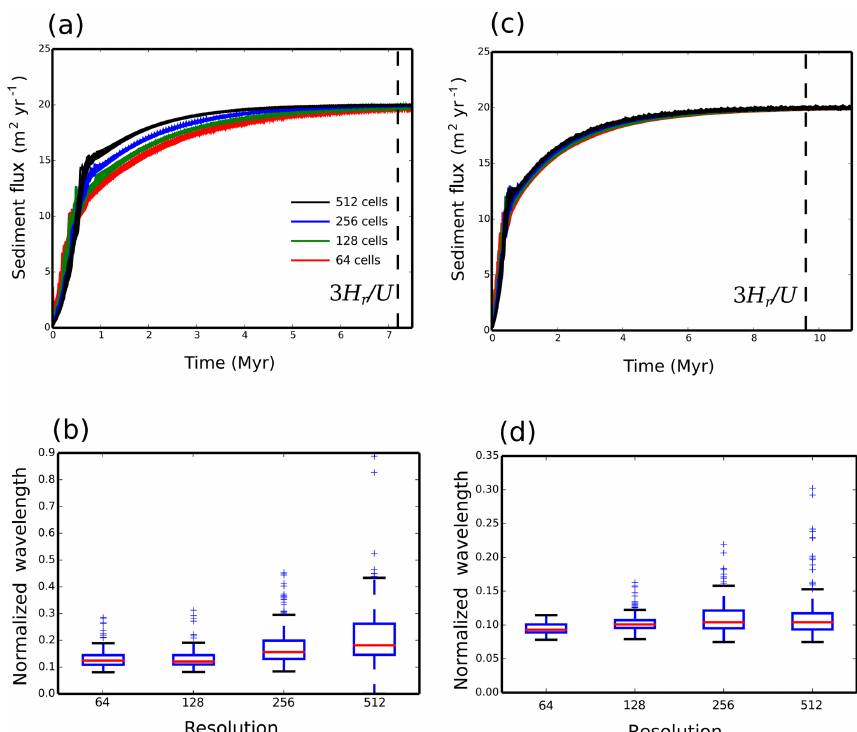
Figure 6. Dimensional sediment flux that exits the model domain and box–whisker plots of the dimensionless valley-to-valley wavelength for each model for different resolutions, where the number of cells along the y axis is shown. (a) Sediment flux and (b) the node-to-node SFD algorithm. (c) Sediment flux and (d) valley-to-valley wavelength for the node-to-node MFD algorithm. The dashed line in panels (a) and (c) marks the time at which erosion balances uplift, given by t ≥ 3 H r /U , where H r is the relief height and U is the uplift rate (Howard,